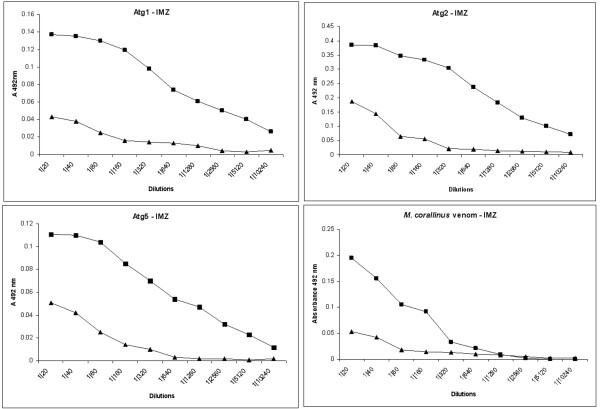
Induction of immune response in BALB/c mice co-immunized with DNA vaccine. Total IgG against a pool of selected antigens (DNA from Atg1, Atg2 and Atg5) were detected through ELISA in plates coated with each of three recombinant proteins or the venom, two weeks after the last immunization. Lines with black triangles and black squares indicate, respectively, pre-immune and final sera (two weeks after the last immunization).